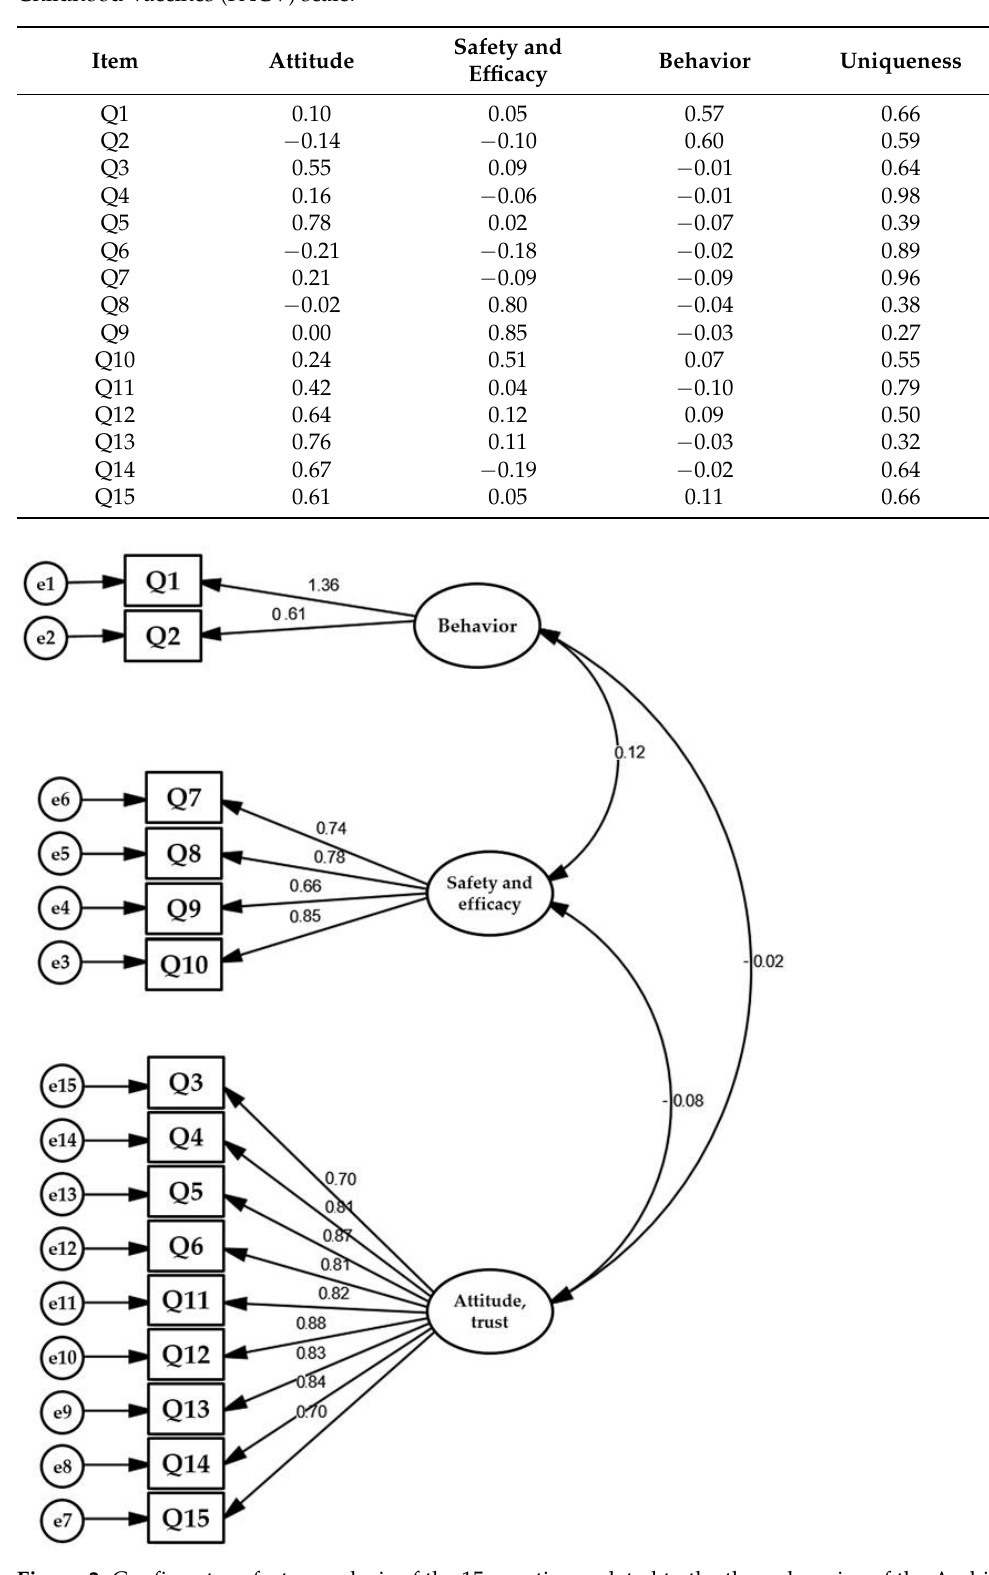
Figure 2. Confirmatory factor analysis of the 15 questions related to the three domains of the Arabic version of the Parent Attitudes About Childhood Vaccines (PACV) scale.